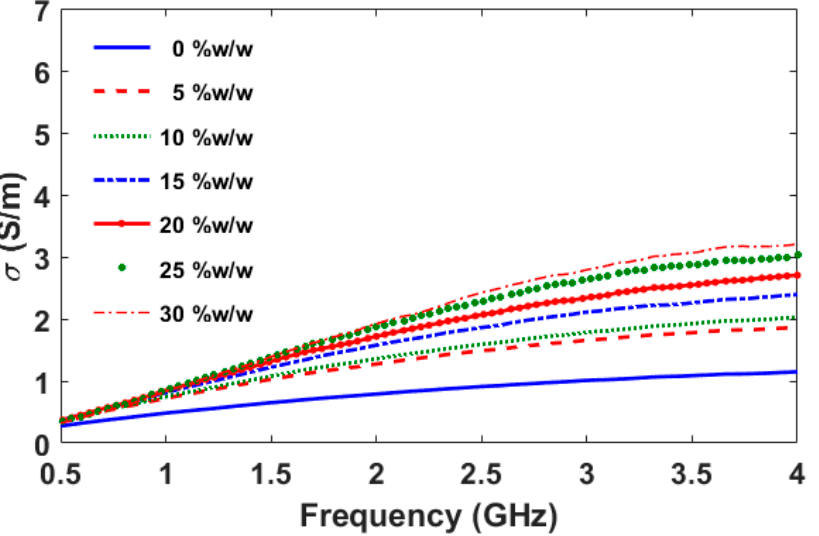
Figure 9. Electrical conductivity of honey, which is adulterated by water with different concentrations over the frequency range of 0.5–4.0 GHz at the temperature of 25 °C.